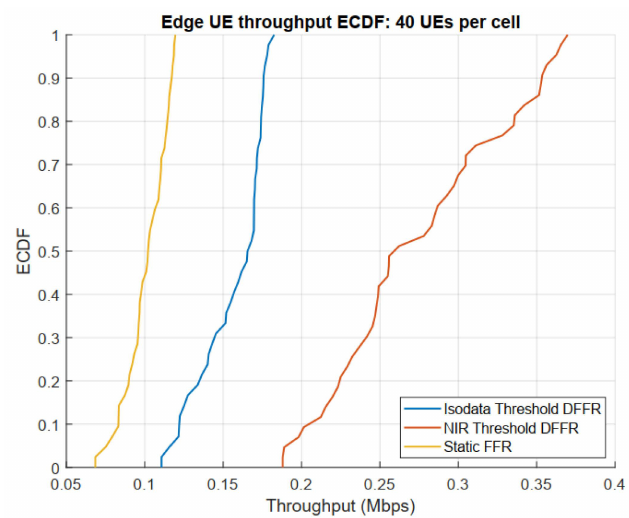
Figure 10. Edge UE throughput ECDF for 40 UEs per cell.